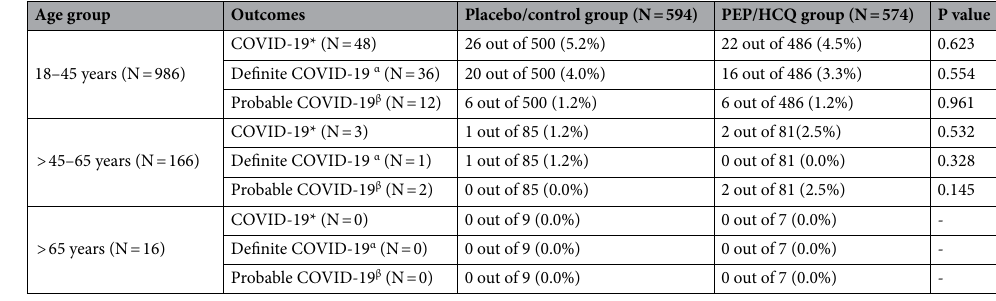
Table 3. Incidence of COVID-19 after post exposure prophylaxis with HCQ and placebo in different age groups. *The participant with either definite or probable COVID-19 was defined as COVID-19 case. α The participant with RTPCR positive for SARS-CoV-2 and with or without symptoms was defined as definite COVID-19 case. β The participant with new onset COVID-19 related symptoms but RTPCR negative for SARS- CoV-2 or could not be performed for any reason was defined as probable COVID-19